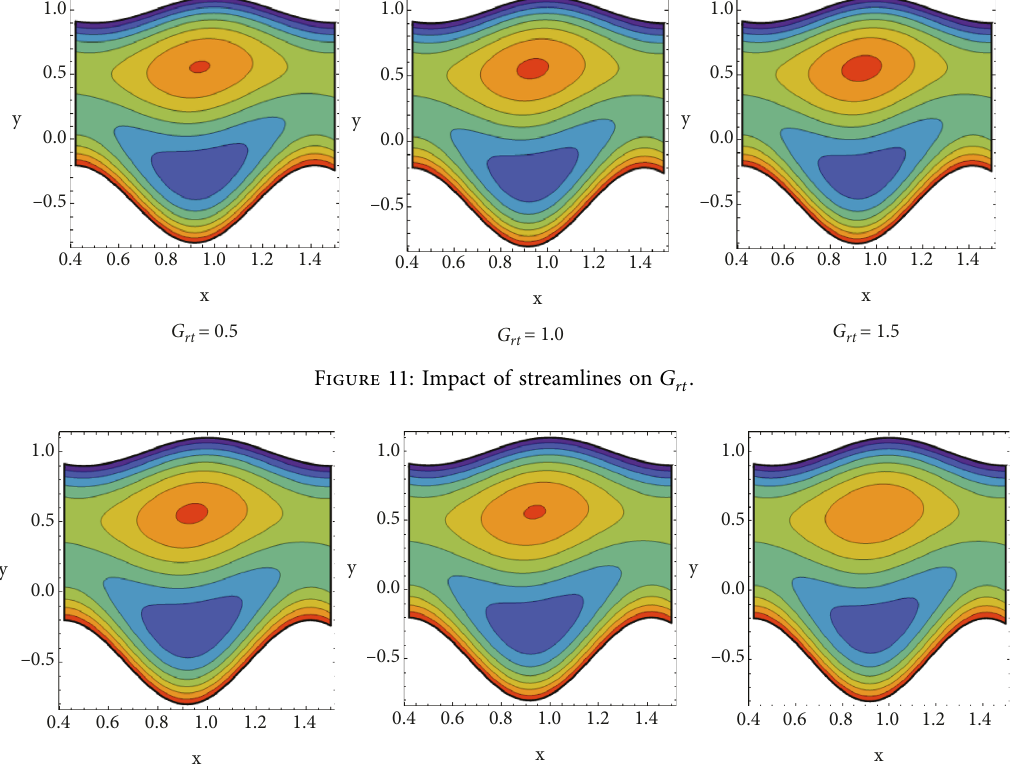
Figure 10: Impact of streamlines on η